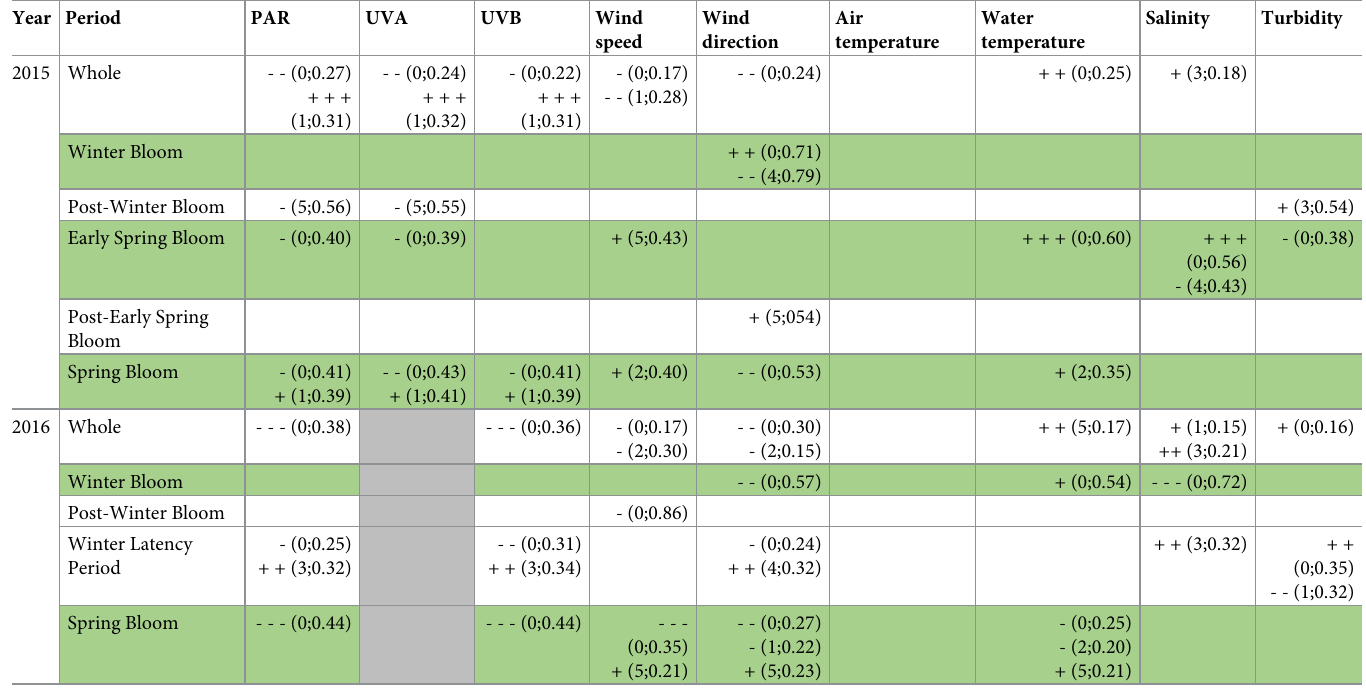
Table 2. Time-lag correlations between meteorological and hydrological